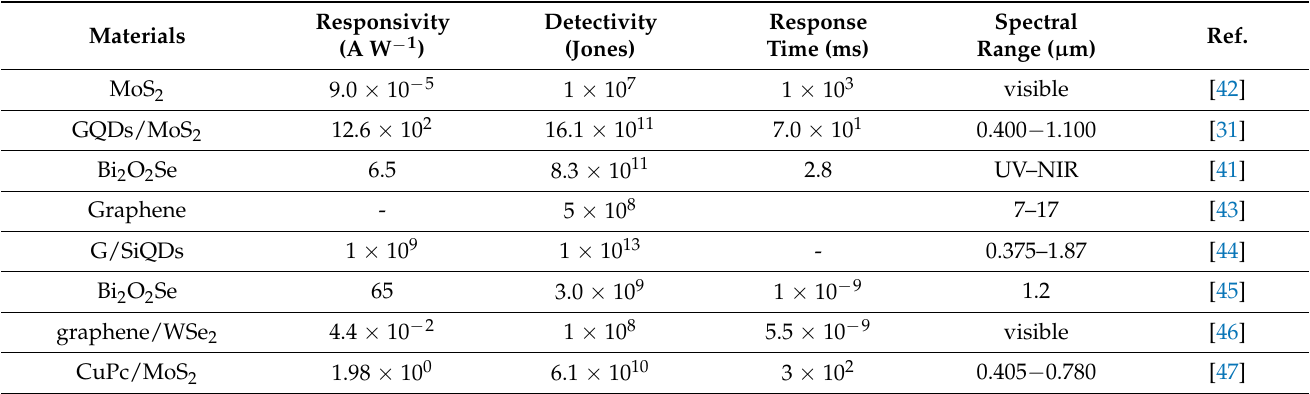
Table 1. Characteristics of photodetectors based on low-dimensional layered materials and their heterostructures.